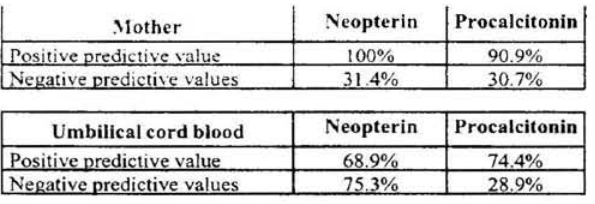
Table 3. Positive and negative predictive values of neopterin and procalcitonin